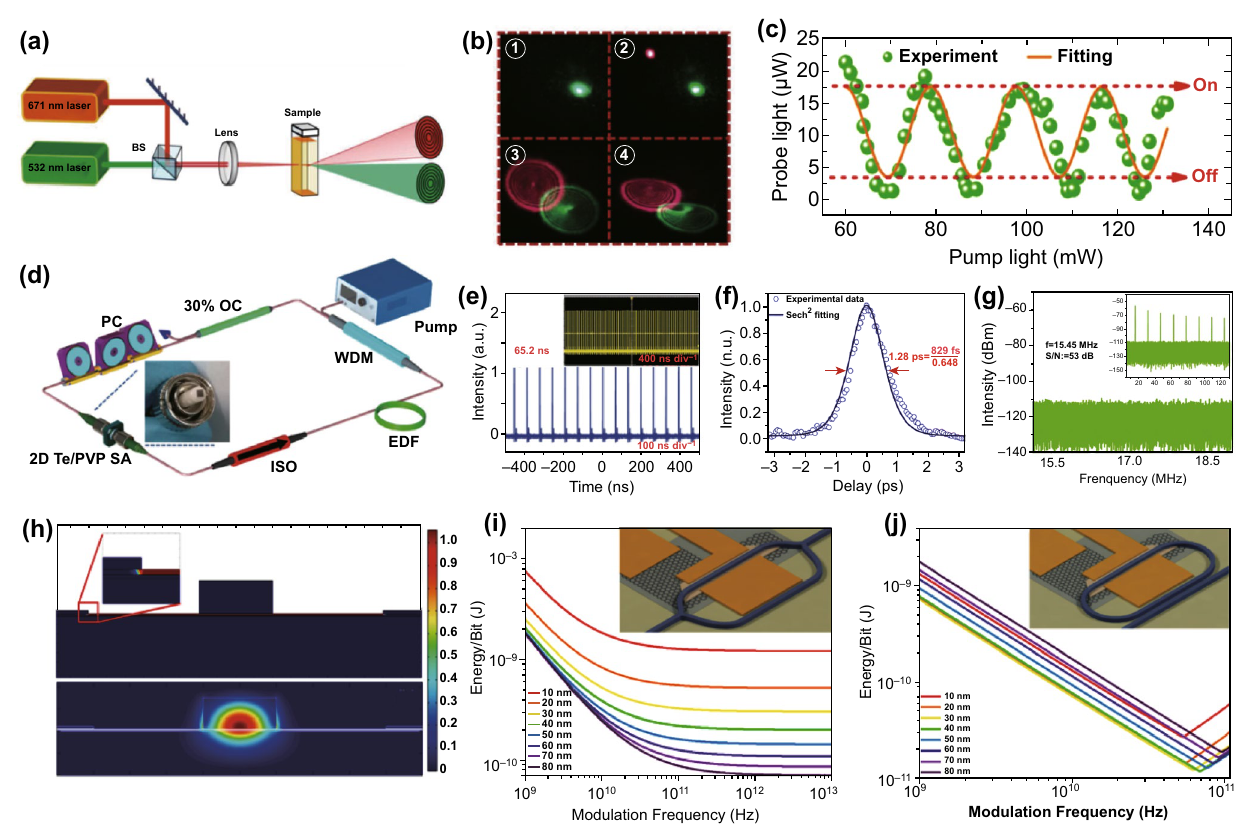
Fig. 15 a Schematic of the all‑optical modulator system based on 2D Te nanoflakes. b Diffraction rings produced by the all‑optical modulator system. c Output of the all‑optical switcher based on 2D Te nanoflakes as a function of pump laser power including the theoretical fit. Adapted with permission from [184]. Copyright 2019, WILEY–VCH. d Schematic of the mode‑locking erbium‑doped fiber laser based on a 2D Te/PVP thin film. e Pulse trains from the fiber laser. Inset: 4 μs pulse trains. f Pulse duration of the modulated femtosecond laser. g Radio‑frequency spectrum of the fiber laser. Inset: broadband radio‑frequency spectrum. Adapted with permission from [185]. Copyright 2019, The Royal Soci‑ ety of Chemistry. h Calculated electric and optical field profiles in the modulator. i Simulated energy consumption of the modulator as a function of frequency for different thicknesses of 2D Te nanoflakes. Inset: schematic of the Mach–Zehnder interferometer (MZI) modulator. j Calculated energy consumption of the Te racetrack modulator as a function of frequency for different thicknesses of tellurene. Inset: schematic of the race‑ track modulator. Adapted with permission from [137]. Copyright 2019, American Chemical